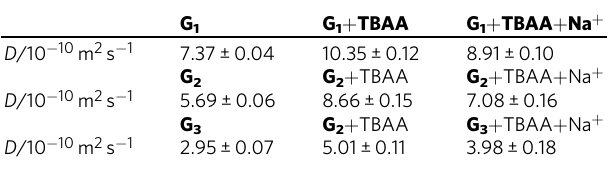
Fig. 5 1 H NMR spectra (THF- d 8 (400 μ L), 298 K, 500 MHz) of solvent-induced switching behavior of rotaxane-branched dendrimer G 3 . a G 3 ; the addition of DMSO- d 6 in a : b 2 μ L; c 4 μ L; d 6 μ L; e 8 μ L; f 10 μ L; g the addition of THF- d 8 (100 μ L) in Table 1 Diffusion coef fi cient ( D ) values of the anion- responsive rotaxane-branched dendrimers G 1 – G 3